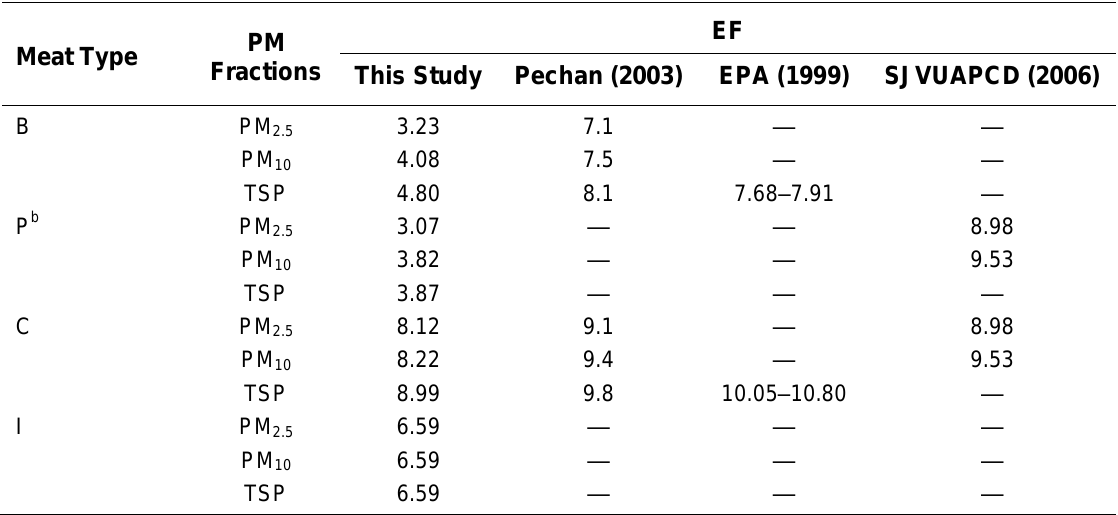
Comparison of Emission Factor (EF) Estimates of Three Major PM Fractions (in g kg -1 ) between Different Studies a